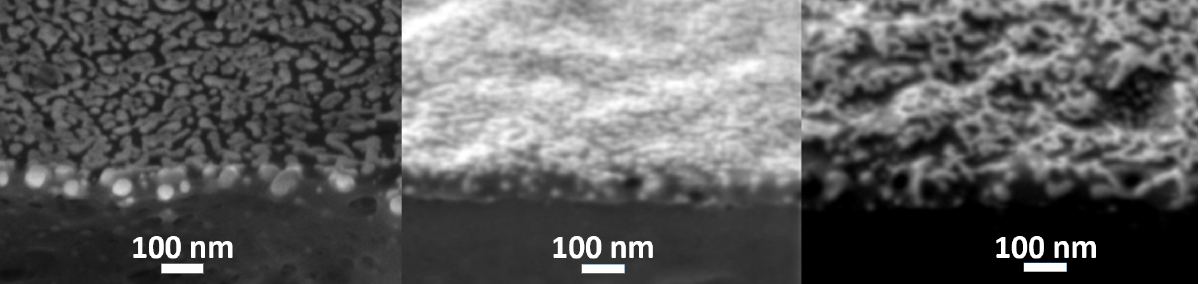
Figure 1. SEM images of selected gold / SA films. Thickness from simulation, from left to right: 4, 5, and 6 nm.